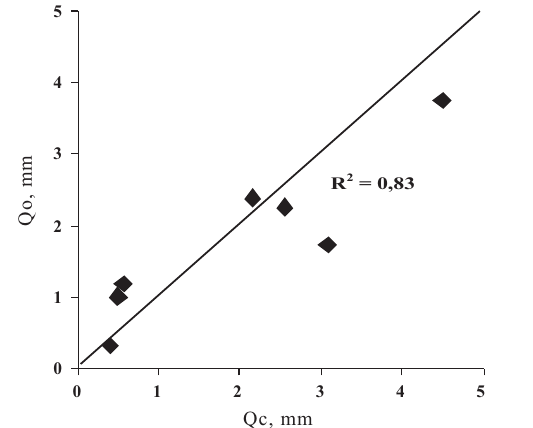
observadaFigura 5. Ajuste obtido entre volumes de escoamento superficial calculados e observados (cenário Quadro 3. Valores anuais, médias e coeficientes de variação (CV) da precipitação pluvial anual (P escoamento superficial (Q) na condição atual (PC), plantio direto (PD) e Cerrado nativo (CER) e vazão média